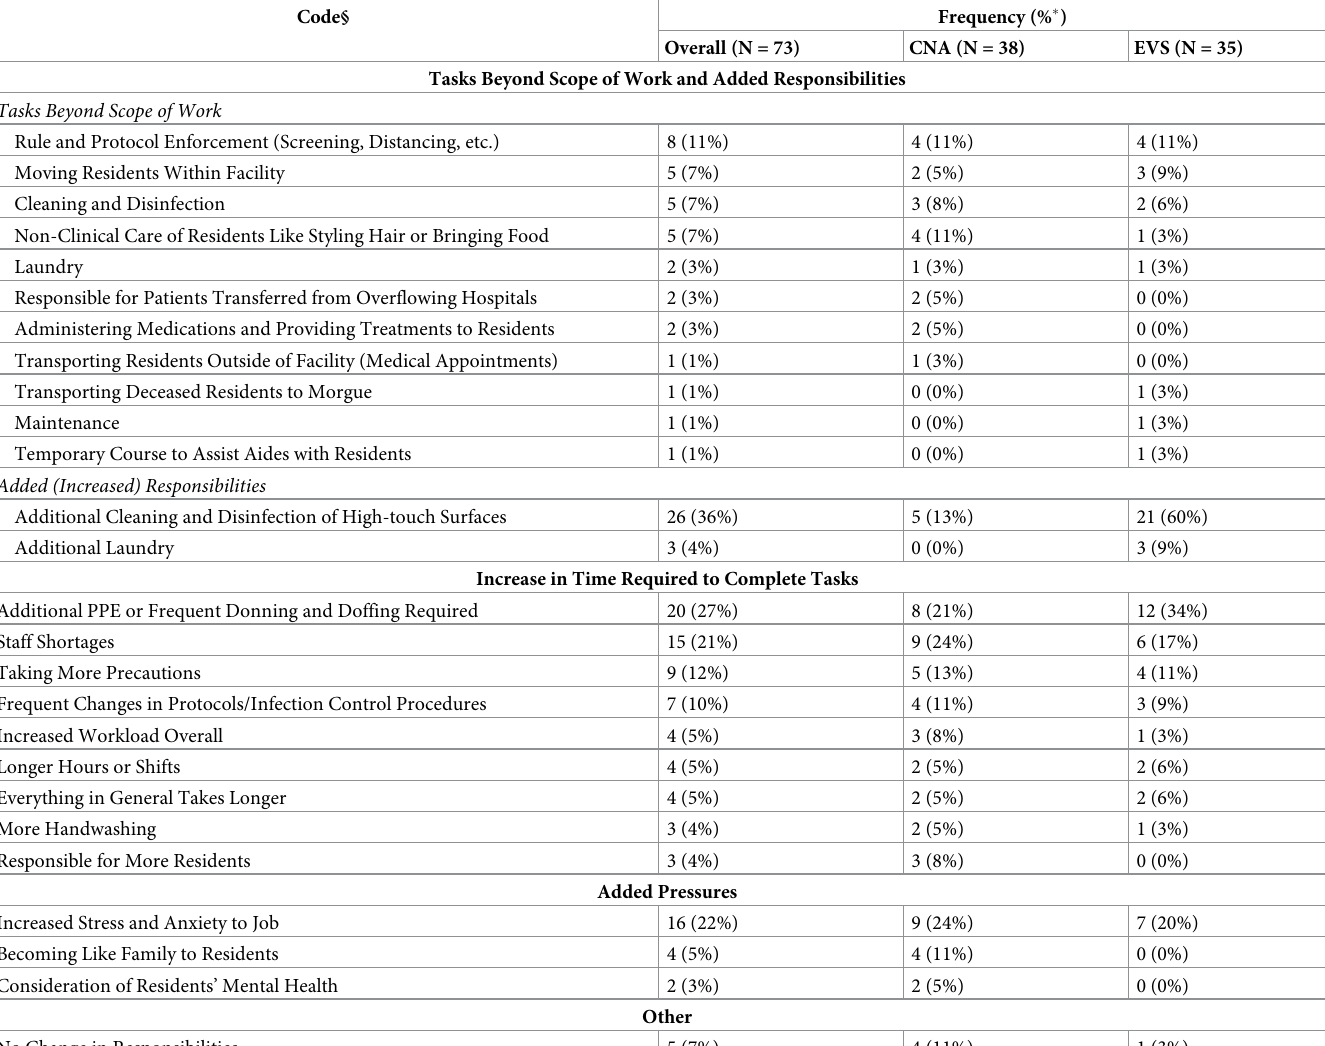
Table 3. Frequency of qualitative codes by theme: How have your job responsibilities changed because of COVID-19?.